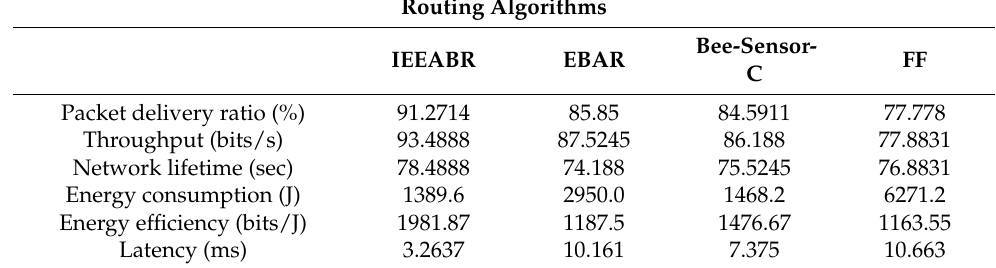
Table 5. Summary of simulation results of routing protocols using different metrics.